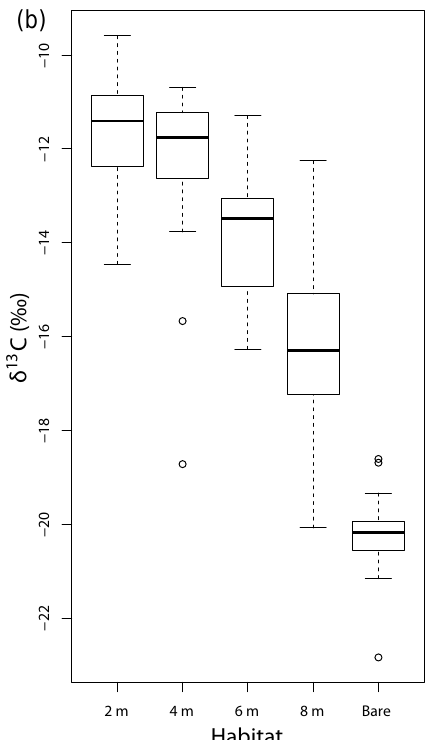
Figure 2. (a) Sediment grain-size contents in P. sinuosa meadows (at 2, 4, 6 and 8m depth) and bare sediment cores (normalized for 500-year-old deposits) at Cockburn Sound; (b) δ 13 C signatures of the sedimentary organic carbon in P. sinuosa meadows (at 2, 4, 6 and 8m depth) and bare sediment cores from Cockburn Sound (nor- malized for 500-year-old deposits). Box plot from top to bottom: largest observation, upper interquartile, median, lower interquartile and lowest observation.